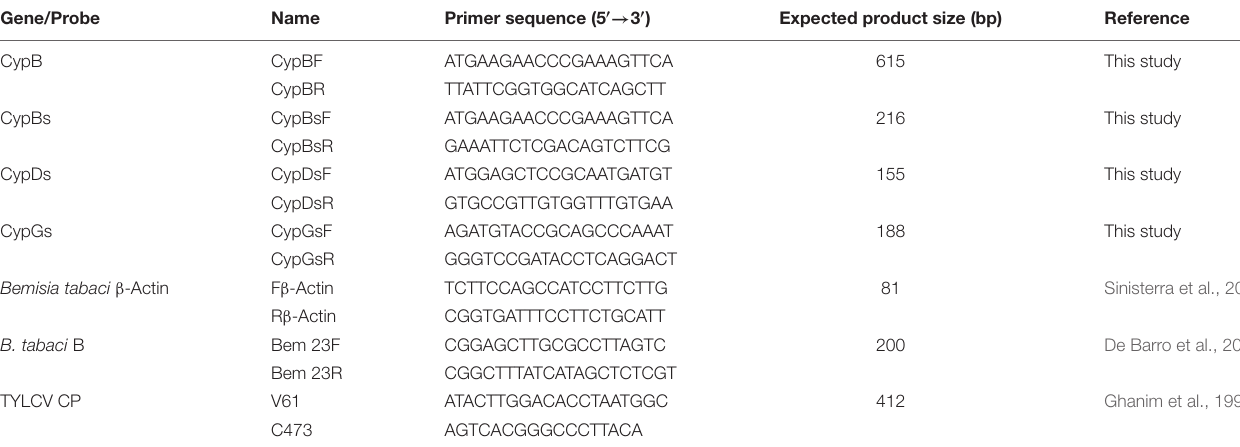
TABLE 1 | Primers used in this